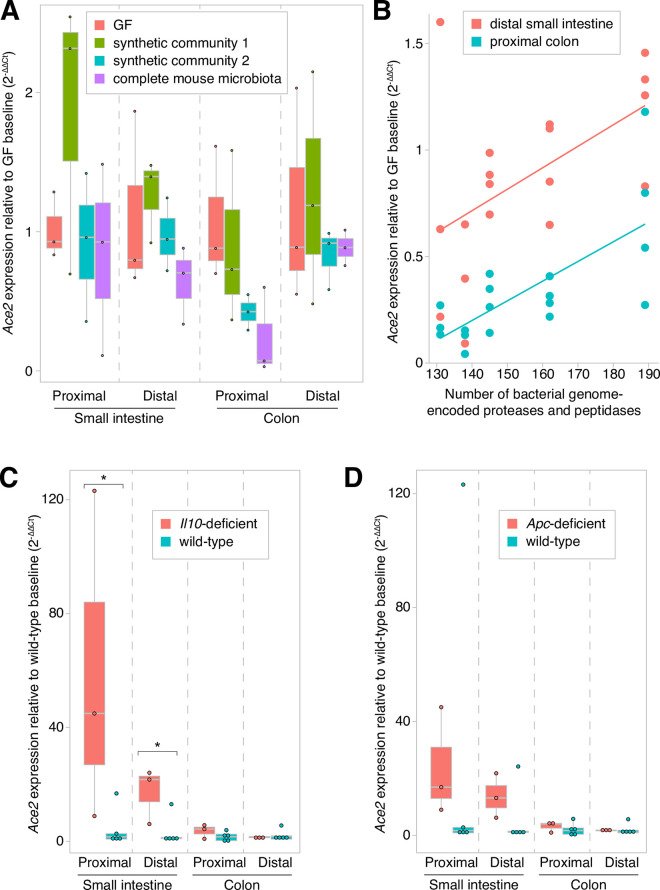
Variability in intestinal Ace2 expression in mice.Gut Ace2 expression varied in relation to (A) different microbiota, (B) microbially-encoded proteases and peptidases, (C) Il10-deficiency, and (D) Apc-deficiency. Statistical significance was determined using a two-tailed Student’s t-test; *, p<0.05.